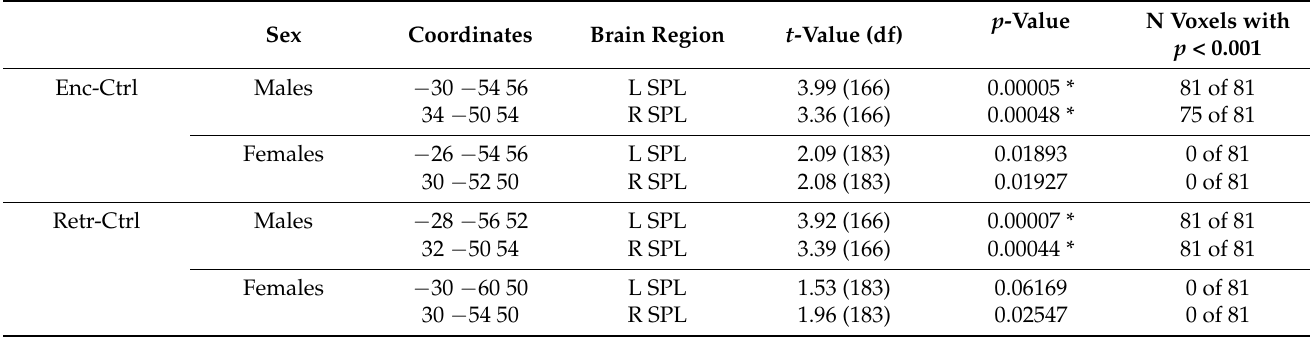
Table 4. Peak values of activation negatively associated with polygenic risk for schizophrenia during episodic memory from sex-stratified analyses within the SPL regions of interest.